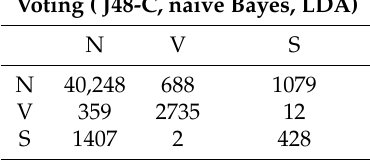
Table 24. Confusion matrix for combining J48-C, naïve Bayes, and LDA classifiers using Voting scheme (N,S,V).